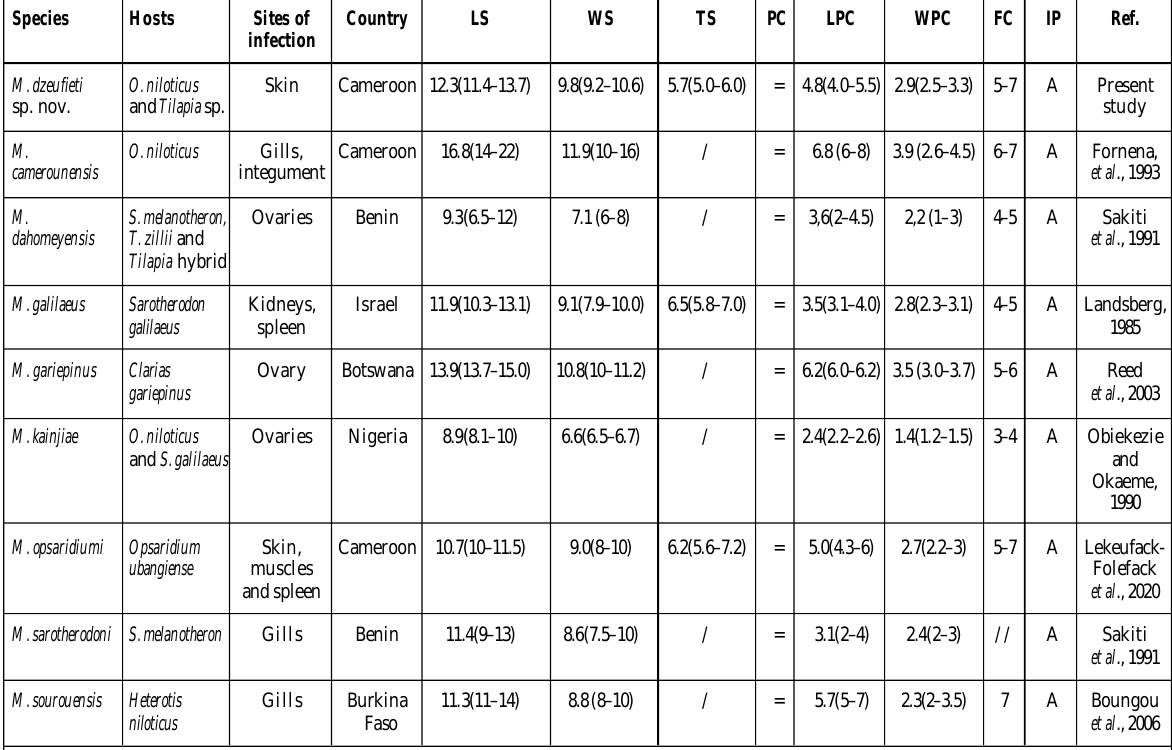
Table 2: Comparative description of Myxobolus dzeufieti sp. nov.with morphologically similar species (measurements in